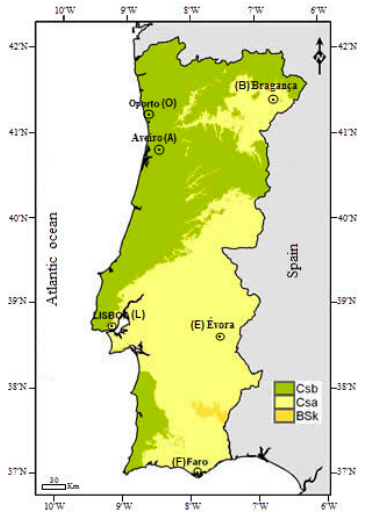
Figure 5. Portugal mainland: Six regions under study (Source: Adapted from Reference